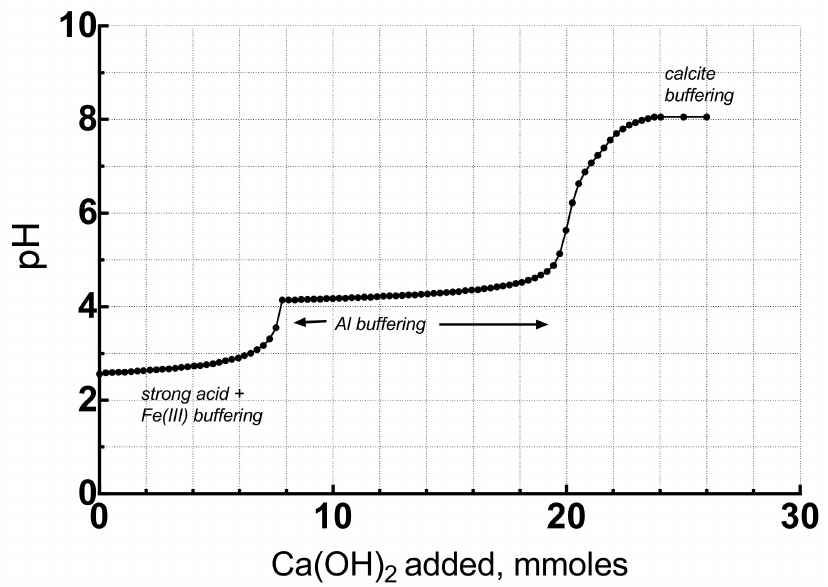
Figure 6. Titration of slaked lime or portlandite with AMD from Berkeley Pit water, showing the main bu ff ering mechanisms with lower overall acidity than the Leviathan Mine water.